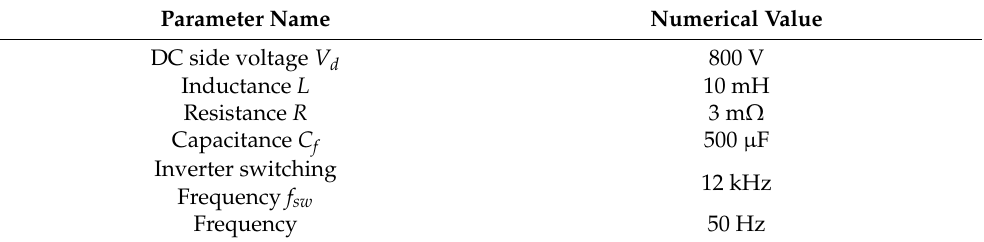
Table 1. DG circuit